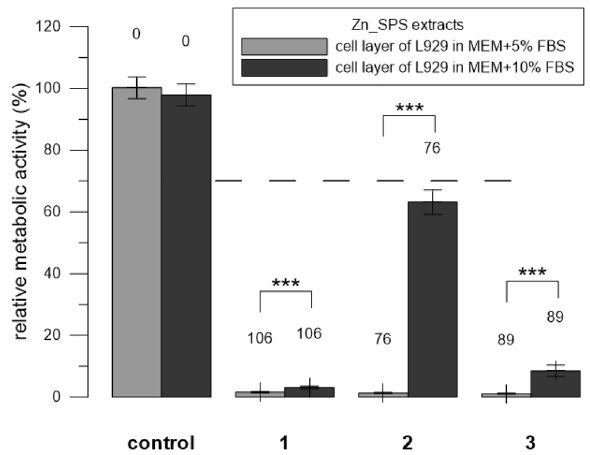
Figure 3. Relative metabolic activity of L929 cells (resazurin assay) after 24 h incubation with extracts of Zn_SPS. Three replicates 1–3 were used. Extracts were prepared in medium either with 5% or with 10% FBS. Sole extraction medium served as a control (unaffected cells which metabolic activity was taken as 100%). Numbers above the columns stand for the concentration of measured Zn in µM. The dashed line stands for the normative limit of 70% metabolic activity of the control. Error bars stand for the standard error deviation of six measurements. Significance codes according to p value: 0 ‘***’0.001 ‘**’0.01 ‘*’0.05 (two-sample t-test).